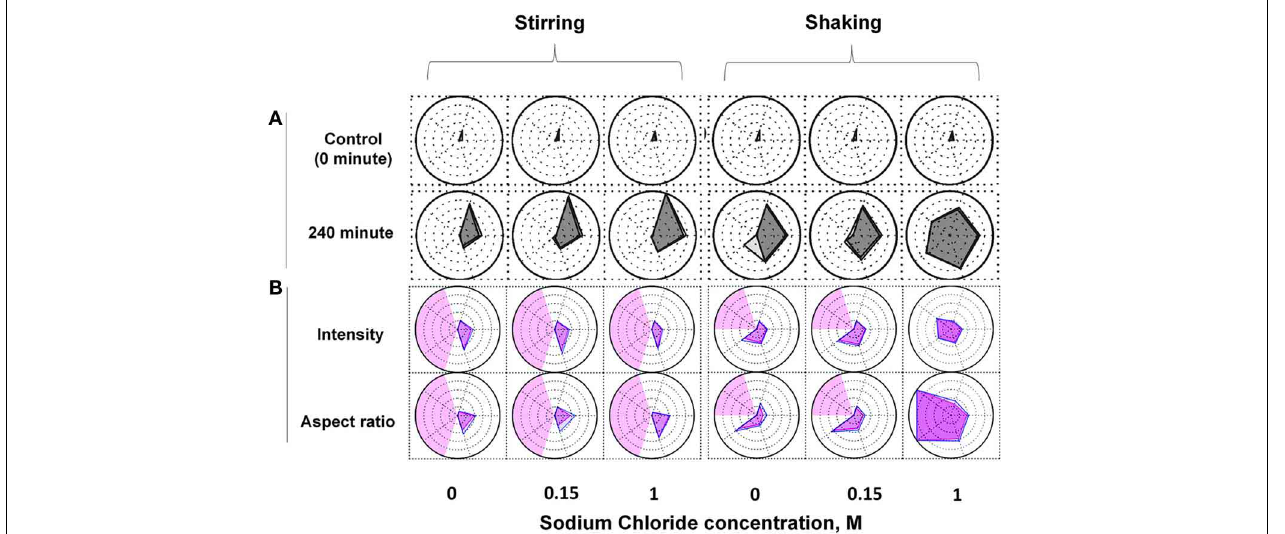
FIGURE 6 | Radar chart analysis of subvisible particles in IgG1mAb solution after stirring and shaking stresses in the presence of varying amount of sodium chloride. The size and number (A) and morphology (B) of subvisible particles were measured by Micro Flow Imaging (MFI). Each axis in an individual radar chart represents particles of various size ranges (clockwise from top: 2–5, 5–10, 10–25, 25–50 and 50–70 μ m). Each ring positioned from the center to periphery displays in (A) 10 fold increase in particle concentration